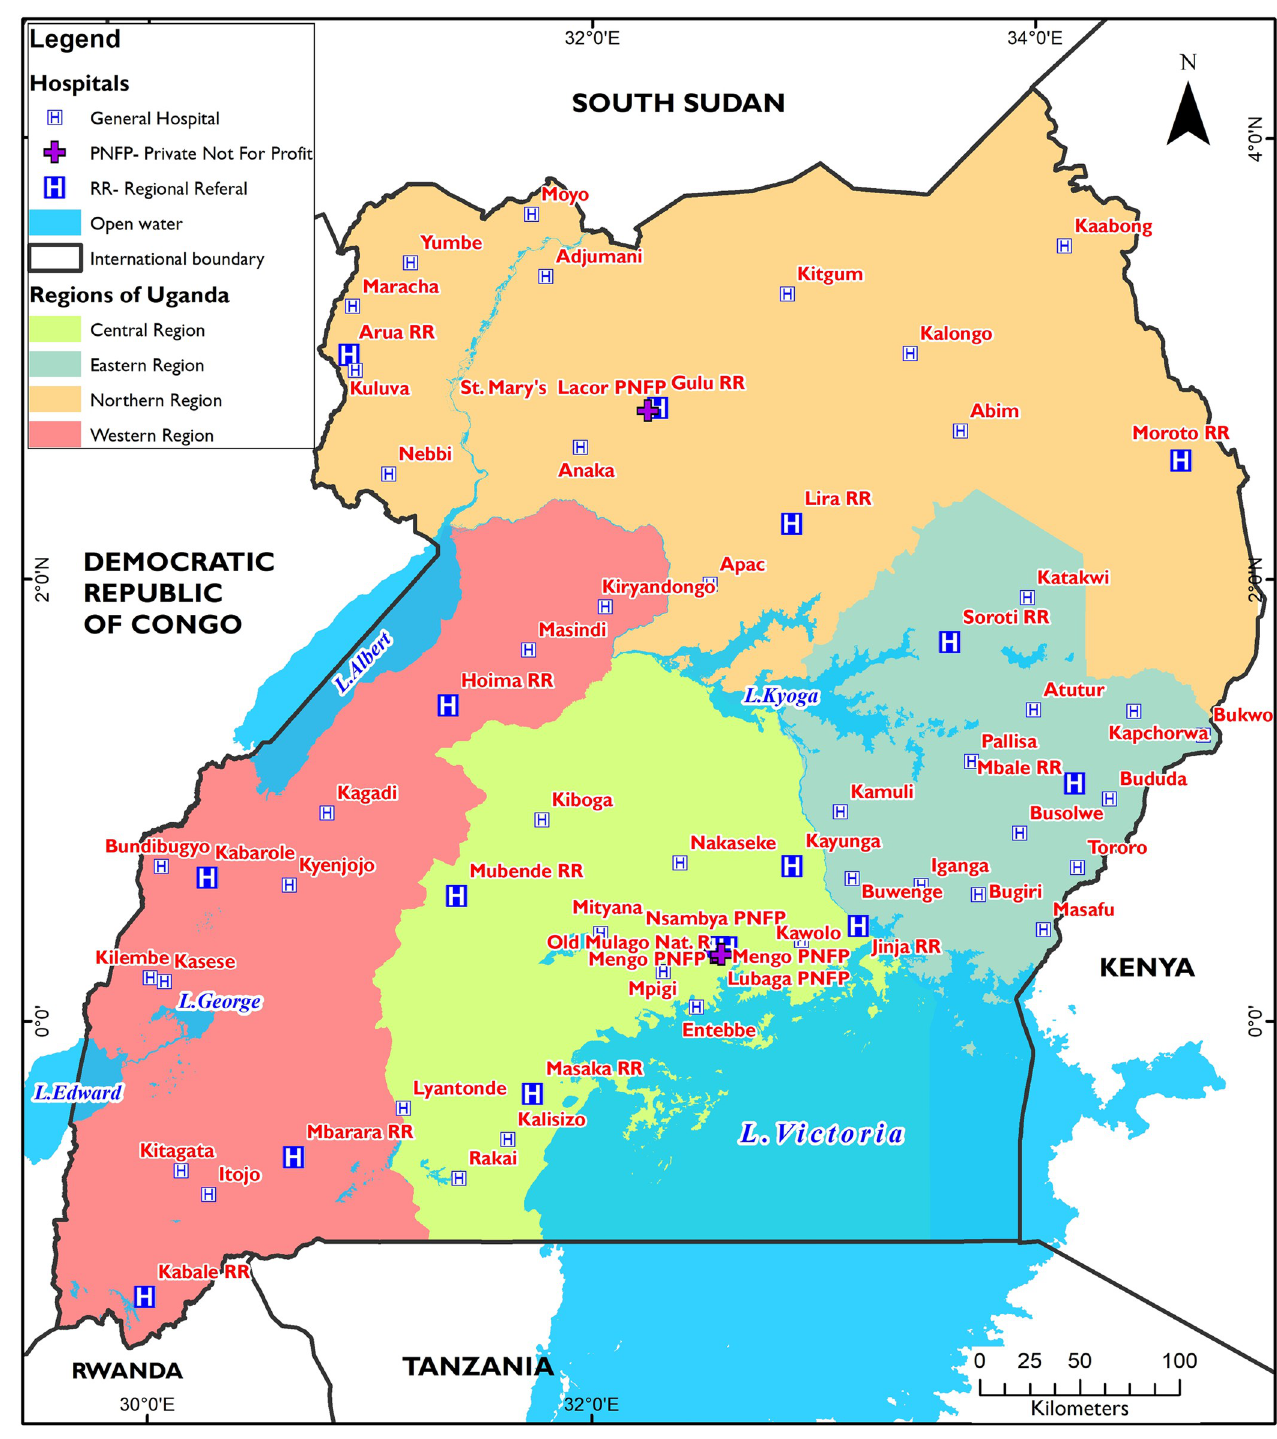
Fig 1. Map showing hospitals included in the study setting.